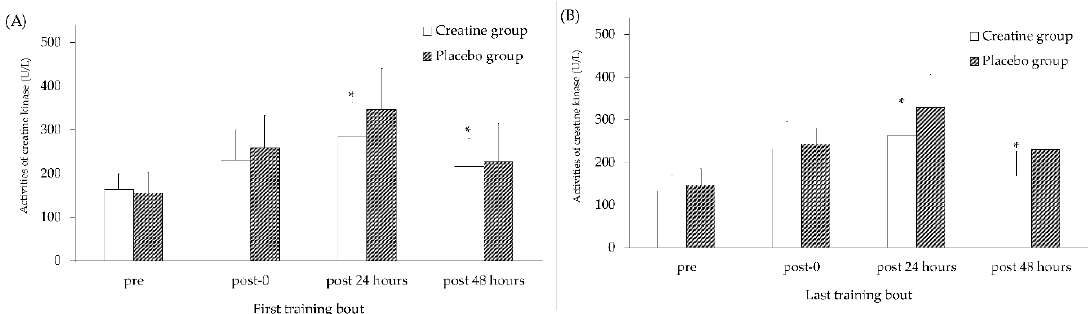
Figure 1. Creatine kinase activity in the creatine and placebo groups after ( A ) the first and ( B ) last training bouts. All values after training were significantly increased compared with pre-training values in both groups ( p < 0.05). * Indicates a significant difference ( p < 0.05) from the placebo group at the same time point.